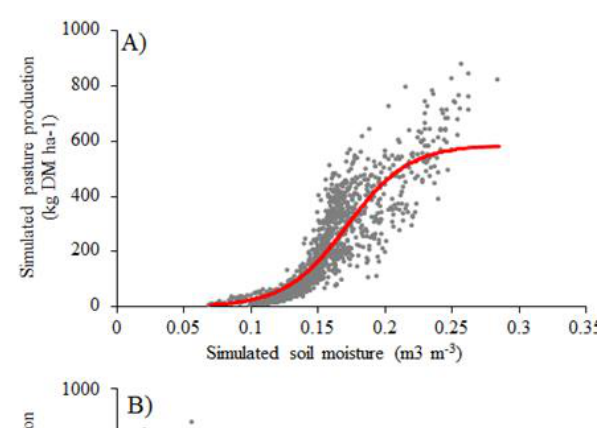
Figure 11. Scatterplot between average pasture production simulated and A) average soil moisture simulated, B) slope, and C) canopy cover.